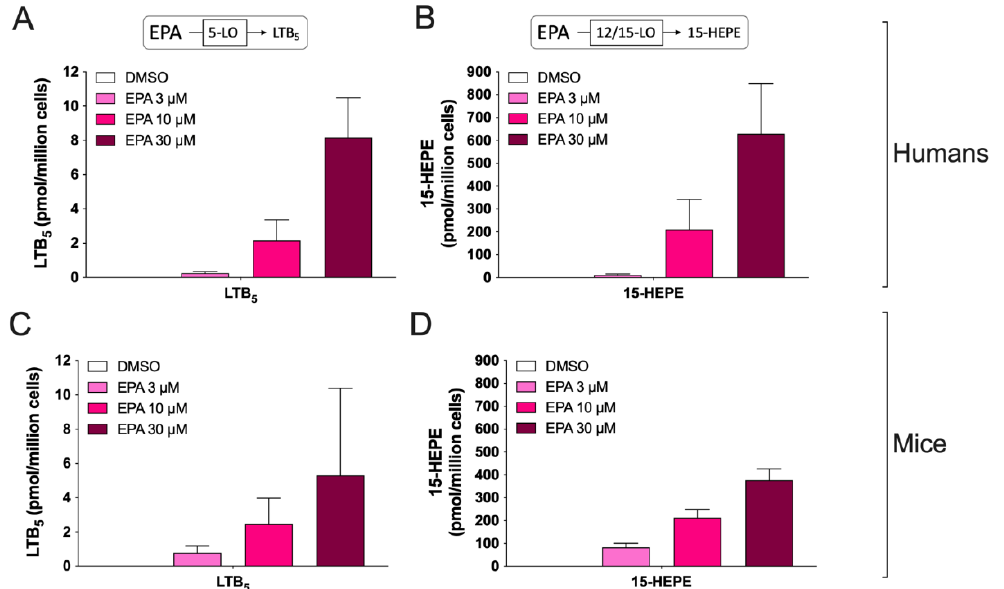
Figure 2. Biosynthesis of EPA-derived eicosanoids from human and mouse eosinophils. EOS suspensions (5 × 10 6 cells/mL, 37 ◦ C) were incubated with DMSO or increasing concentrations of EPA for 15 min. Incubations were stopped by adding one volume of cold (−20 °C) MeOH containing the internal standards. Samples were then processed and analyzed for eicosanoids by LC-MS/MS as described in Materials and Methods. ( A , B ) Results are the mean (± SEM) of 6 independent experiments using human eosinophils from asthmatic donors. ( C , D ) Results are the mean (± SEM) of 7 independent experiments using bone marrow-derived mouse eosinophils.